Question: Author a descriptive caption for the visualization shown.
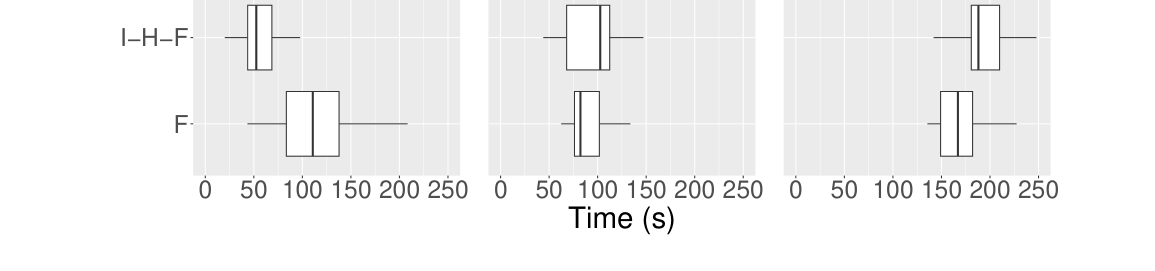
Answer: Simulation 1: boxplots of computational time (s) for each model selection approach and different values of n.